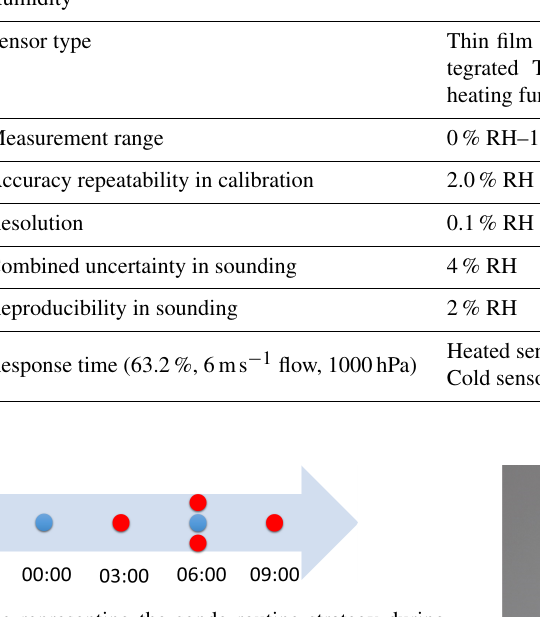
Figure 2. Scheme representing the sonde routine strategy during DACCIWA IOPs, with RS41-SG (blue) and Windsond S1H2-R (red) time in UTC.